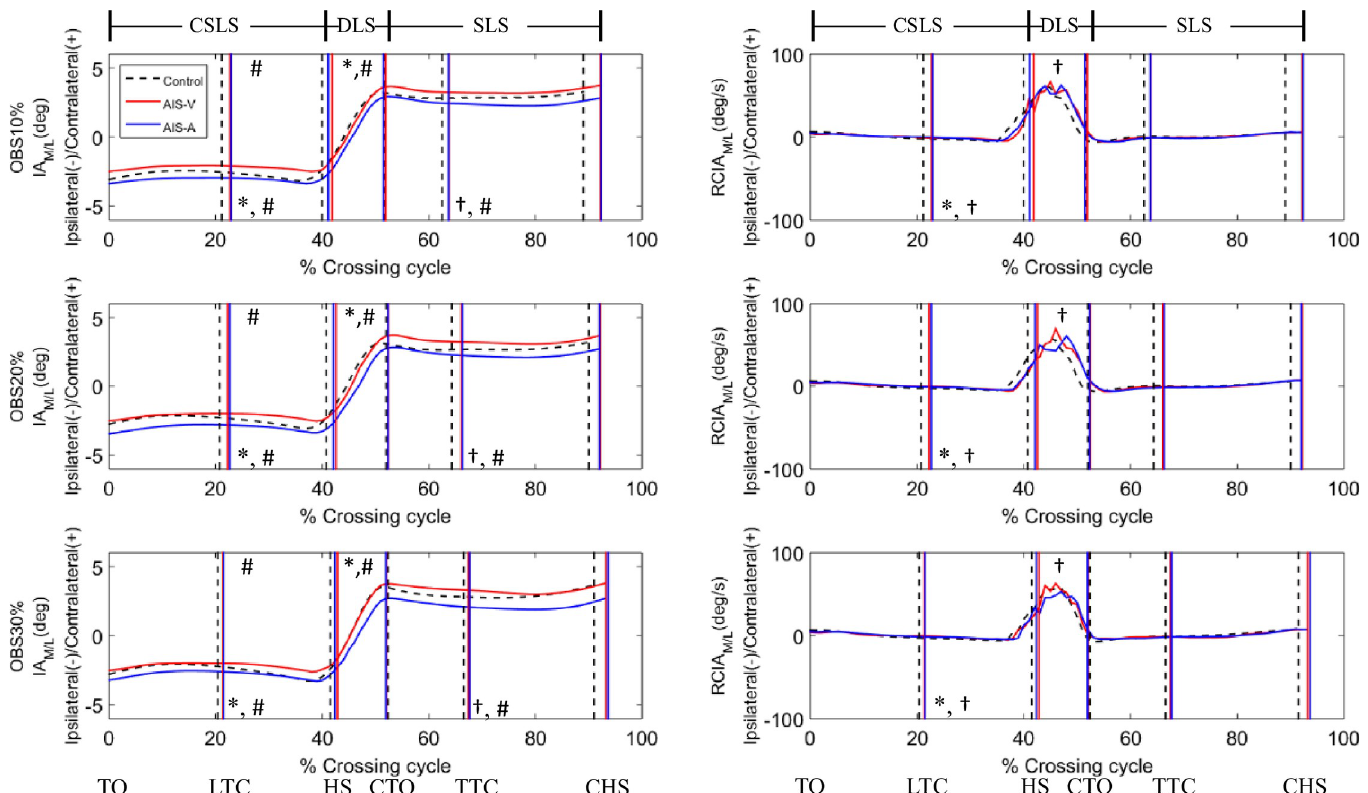
Fig 3. Ensemble-averaged curves of COM-COP inclination angle (IA) (left column), and rate of change of IA (RCIA) (right column) in the frontal plane over the crossing cycle when crossing obstacles of heights of 10%, 20% and 30% the leg length (LL) for convex side, concave side and control, drawn with data points at an interval of 1% crossing cycle. The medial/lateral (M/L) position of the COM and COP were described relative to the line of progression that described the M/L range of motion of the COM during a gait cycle, a positive value being to the side of the contralateral limb. (TO: toe-off of the leading limb; LTC: leading toe above the obstacle; HS: heel-strike of the leading limb; CTO: toe-off of the contralateral limb; TTC: trailing toe above the obstacle; CHS: heel-strike of the contralateral limb; SLS: single-limb support of the leading limb; CSLS: contralateral single-limb support; DLS: double-limb support; � : AIS-A significantly different from Control; †: AIS-V significantly different from Control; #: AIS-A significantly different from